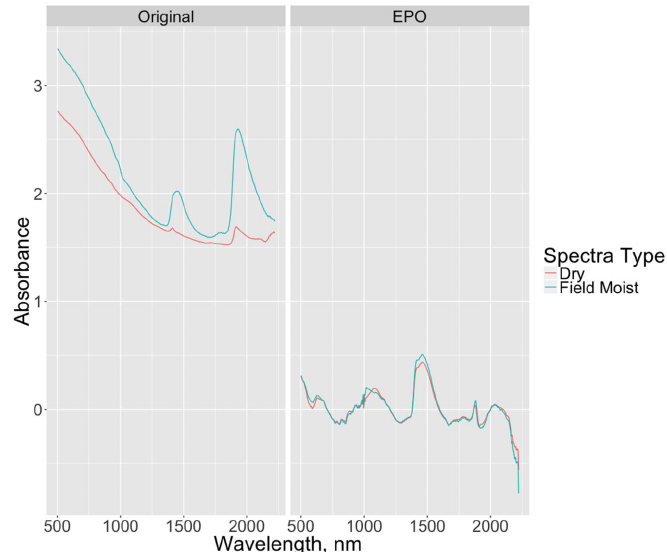
Figure 2. Plots of spectra before and after EPO transformation with six EPO factors for a selected soil sample. Differences in spectral features between the dry and field moist spectra are significantly reduced as a result of the transformation.